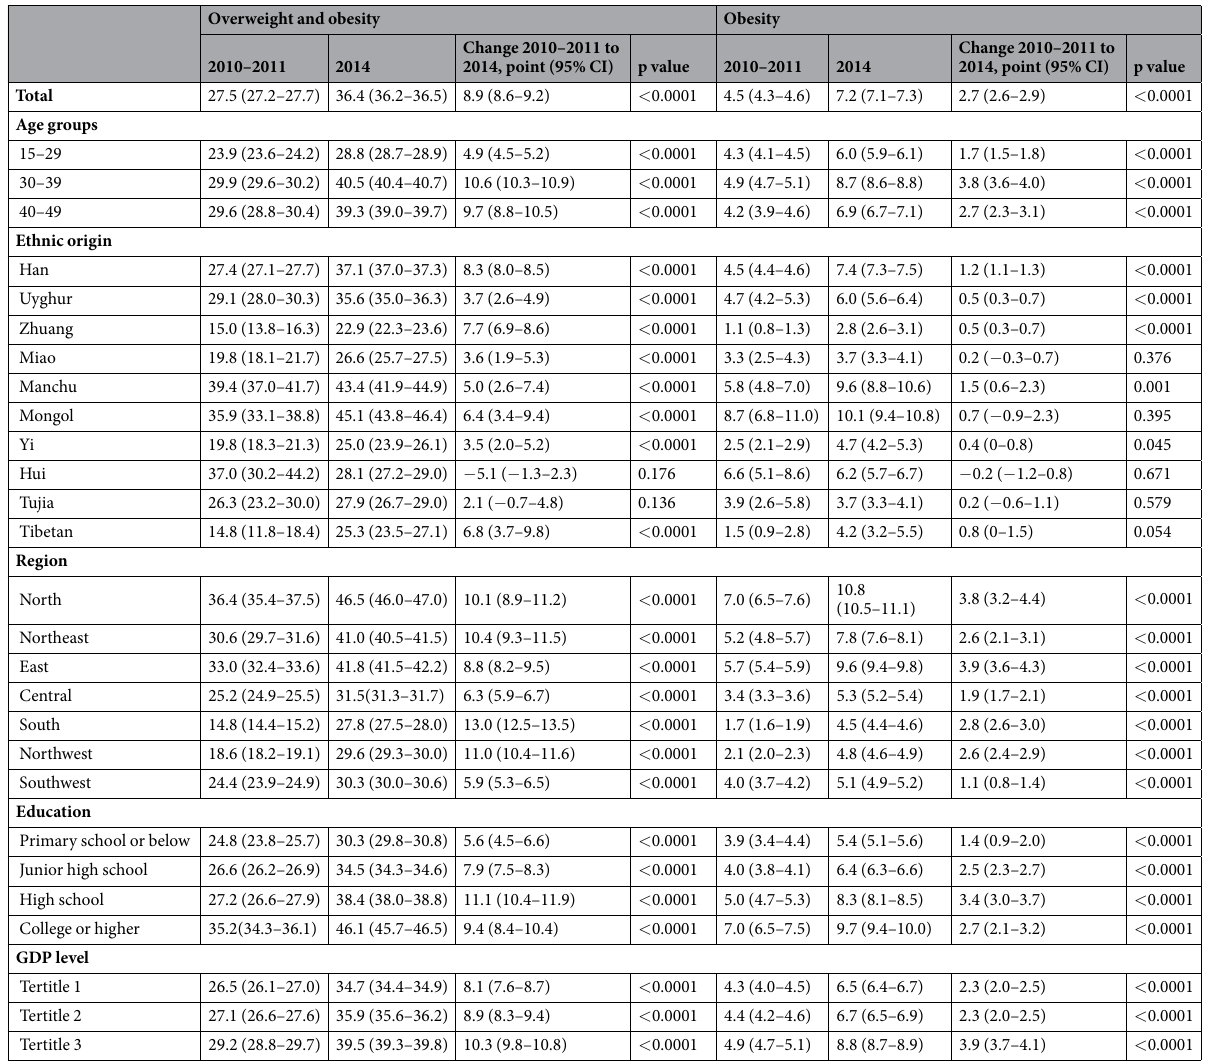
Table 3. Trends in prevalence of overweight and obesity among reproductive-age men aged 15–49 years in rural China, 2010–2014 a . a Data are shown as prevalence (95% confidence interval), and all estimates were weighted using the China Population Census in 2010. The sample size in 2010 was relatively small, thus data from 2010 and 2011 were combined. Overweight and obesity were defined according to the Chinese criteria: overweight, 24.0 ≤ BMI ≤ 27.9 kg/m 2 and obesity, BMI ≥ 28.0 kg/m 2